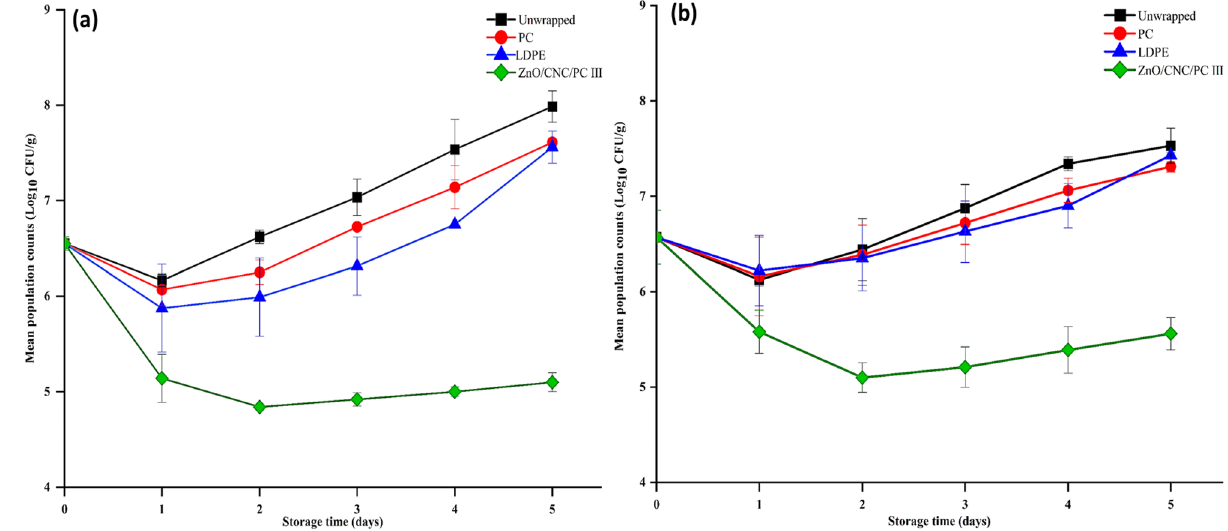
Figure 6. Growth behavior of S. aureus ( a ) and S. enterica ( b ) on unwrapped, LDPE-, PC-, and ZnO/CNC/PC III wrapped roumy